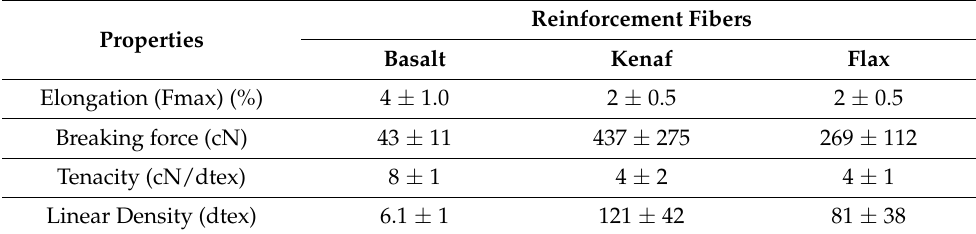
Table 2. Properties of applied fibers (as